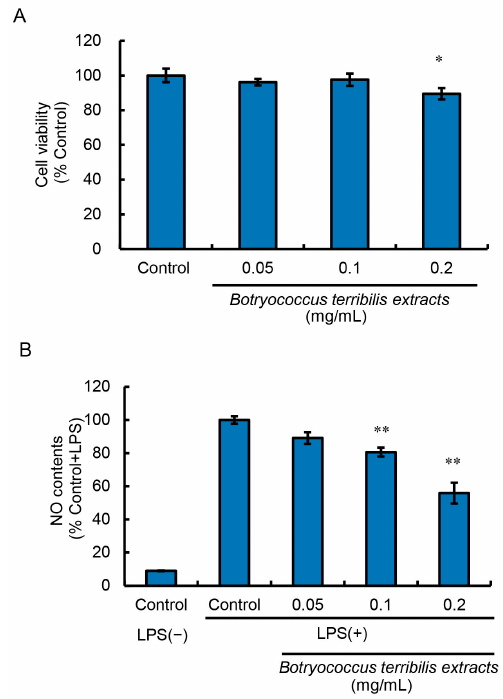
Figure 1. Effect of BTEE on cell viability and LPS-induced NO production in RAW264 cells. ( A ) RAW264 cells were treated with or without BTEE at the concentrations of 0.05, 0.1, and 0.2 mg/mL for 24 h. After treatment, cell viability was measured by MTT assay. Values are expressed as mean ± SD of triplicate experiments and as relative to the percentage of control. ( B ) Cells were treated with or without BTEE at concentrations of 0.05, 0.1, and 0.2 mg/mL for 24 h. After treatment, cells were stimulated with LPS (1 ng/mL) for 16 h. The amount of NO production was measured by the Griess reaction. Values are expressed as mean ± SD of triplicate experiments and as relative to the percentage of control LPS (+). Signi fi cance is indicated as * p < 0.05 or ** p < 0.01.